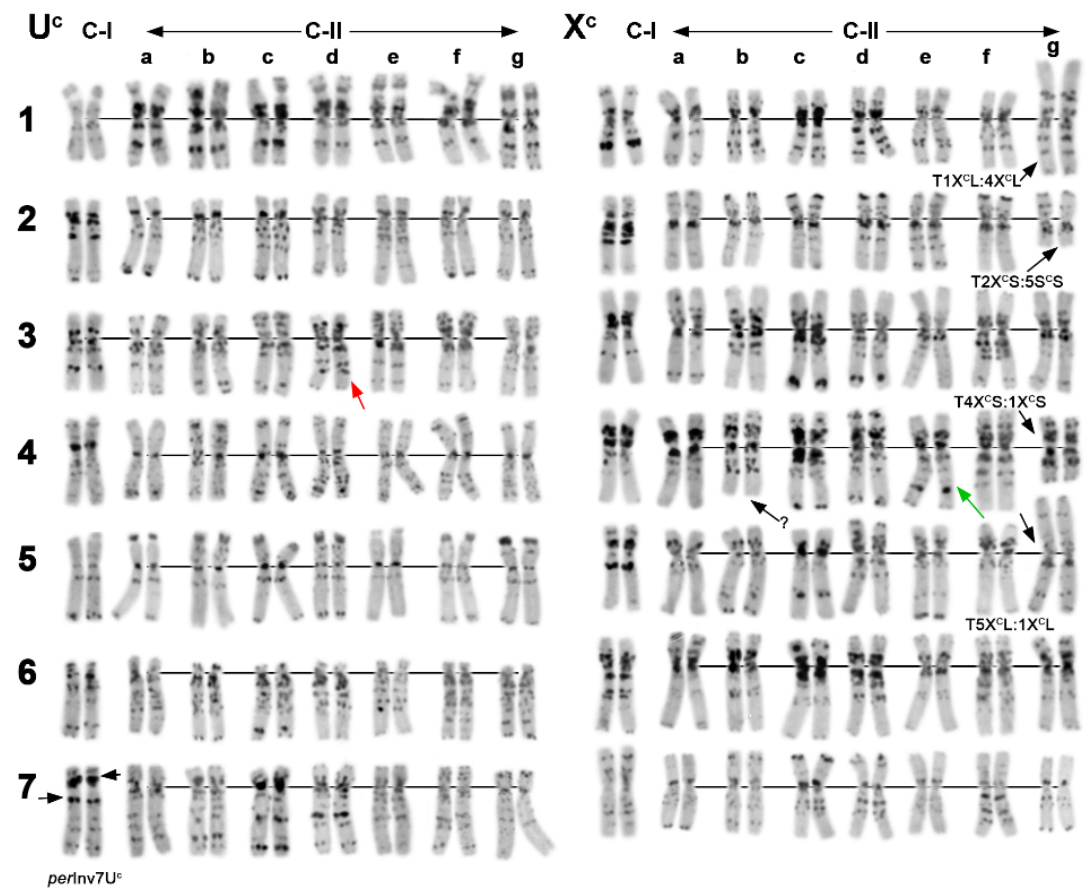
Figure 7. Polymorphisms of the C-banding patterns of Ae. columnaris accessions belonging to group C-II in comparison with C-I accession (i − 570045). ( a )—K − 3899 (Iraq); ( b )—PI 542191; ( c )—PI 564181; ( d )—PI 554182; ( e )—PI 564180; ( f )—PI 564179; ( g )—TA2084 (all from Turkey). C-I accession i − 570045 (=PI 554184) from Turkey is shown for comparison. Rearranged chromosomes are indicated with black arrows. The red arrow indicates a chromosome, which was presumably introgressed from the C-I group; green arrow shows the chromosome, which could be introgressed from Ae. neglecta .